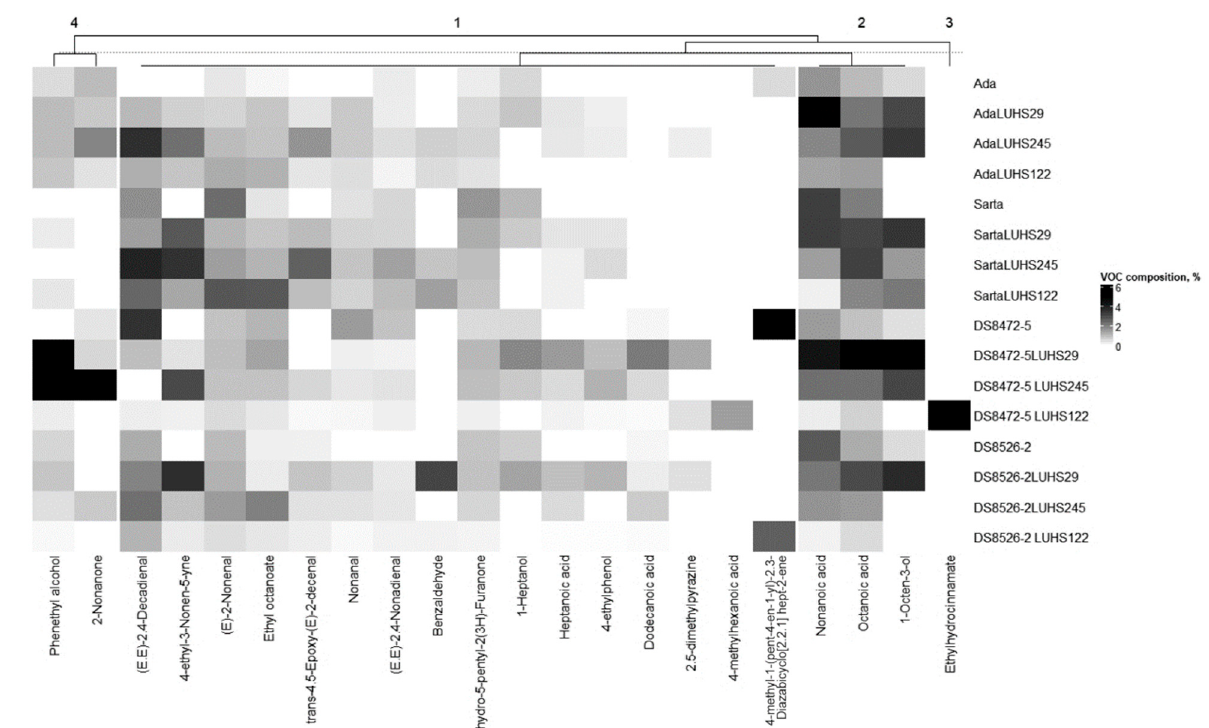
Figure 5. Volatile compounds that are <1% in wheat wholemeal samples (LUHS29—fermented with Pediococcus acidilactici LUHS29 strain; LUHS245—fermented with Liquorilactobacillus uvarum LUHS245 strain; LUHS122—fermented with Lactiplantibacillus plantarum LUHS122 strain. Data are represented as means (n = 3)).